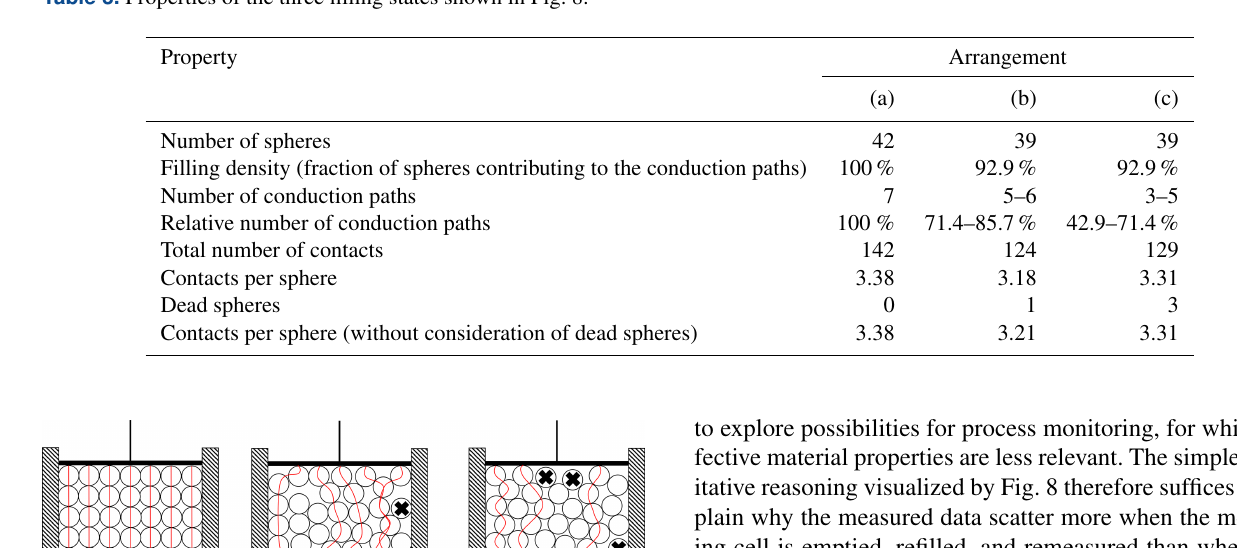
Table 3. Properties of the three filling states shown in Fig. 8.